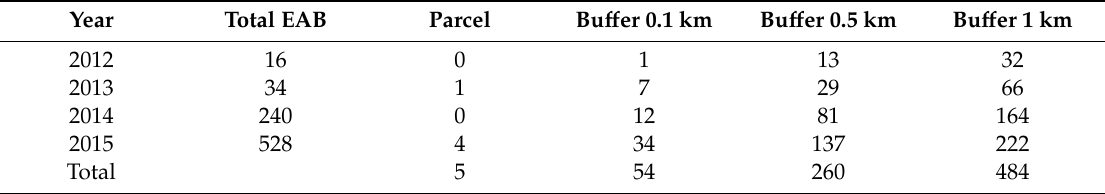
Table 2. The Number of emerald ash borer (EAB) Infested Ash Trees and Impacted Properties with Sales. Year Total EAB Parcel Bu ff er 0.1 km Bu ff er 0.5 km Bu ff er 1 km 2012 16 0 1 13 32 2013 34 1 7 29 66 2014 240 0 12 81